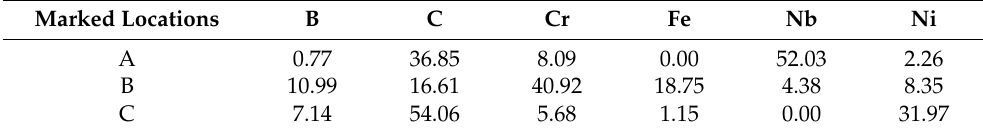
Figure 4. Microstructure ( a ) and element distribution ( b ) of coatings with ultrasonic vibrations. Table 4. Point scan results marked at different positions in Figure 4a.